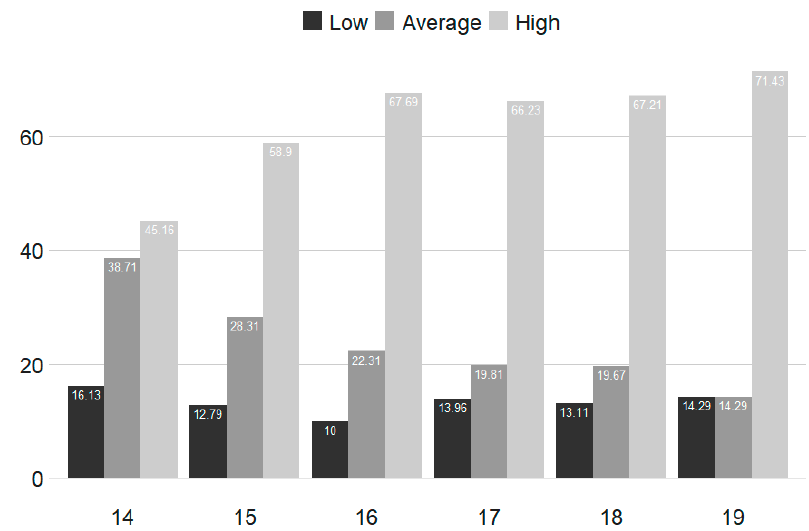
Figure 2. Gambling frequencies by age (%) for T 2 ( n = 1023 individuals who gambled within the past 12 months).